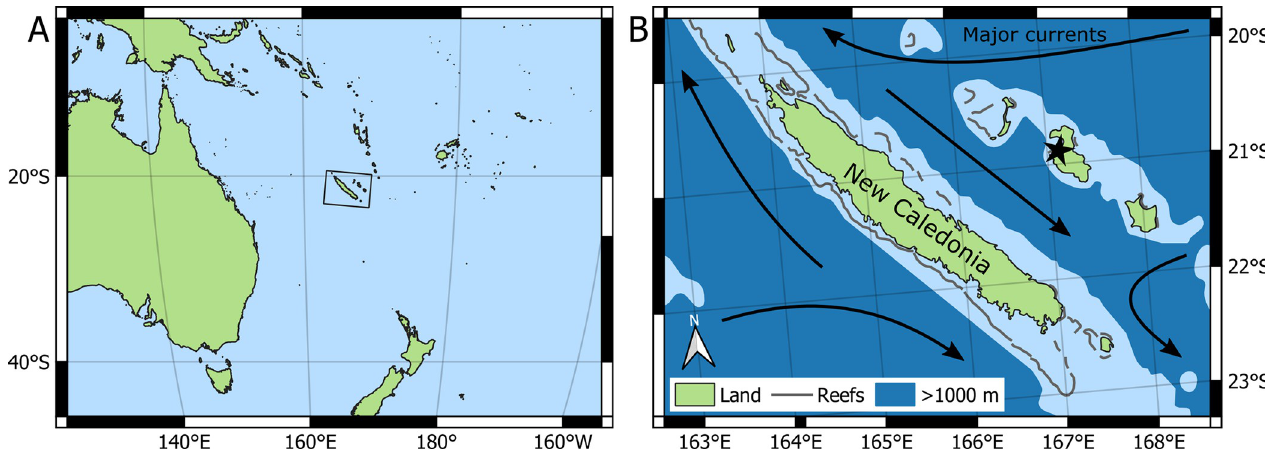
Fig 2. Map showing the sample collection location and major currents surrounding New Caledonia. A) World map showing the location of New Caledonia in the Southwestern Pacific Ocean. B) Local map showing New Caledonia and the surrounding islands with a star indicating the location of the cenote. Water shallower than 1000 m is in light blue and approximates the habitat of N. macromphalus . around New Caledonia. All cenote specimens are from the star location of Lifou, Loyalty Islands [34]. All other specimens were collected near the large island and are recent museum specimens. Reliable accounts of the live collection of N . macromphalus are mostly known from areas close to New Caledonia, and the species is thought to have a geographic range restricted to that region [35]. Local currents are overlain for reference [36].